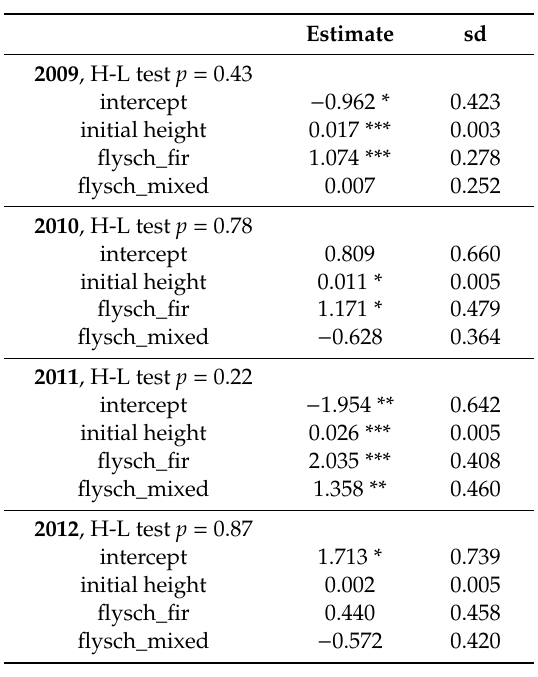
e ff ect of flysch_fir compared to ls_fir of varying magnitude (Table 6). The strongest e ff ects of site on survival were observed in 2011, a year of low summer rainfall. Table 6. Logistic regression parameter values (statistical significance ***: p < 0.001 ***, **: p < 0.01, *: p < 0.05) and Hosmer–Lemeshow goodness of fit test (g = 10). Correlation coe ffi cients for site groups concern di ff erences with group